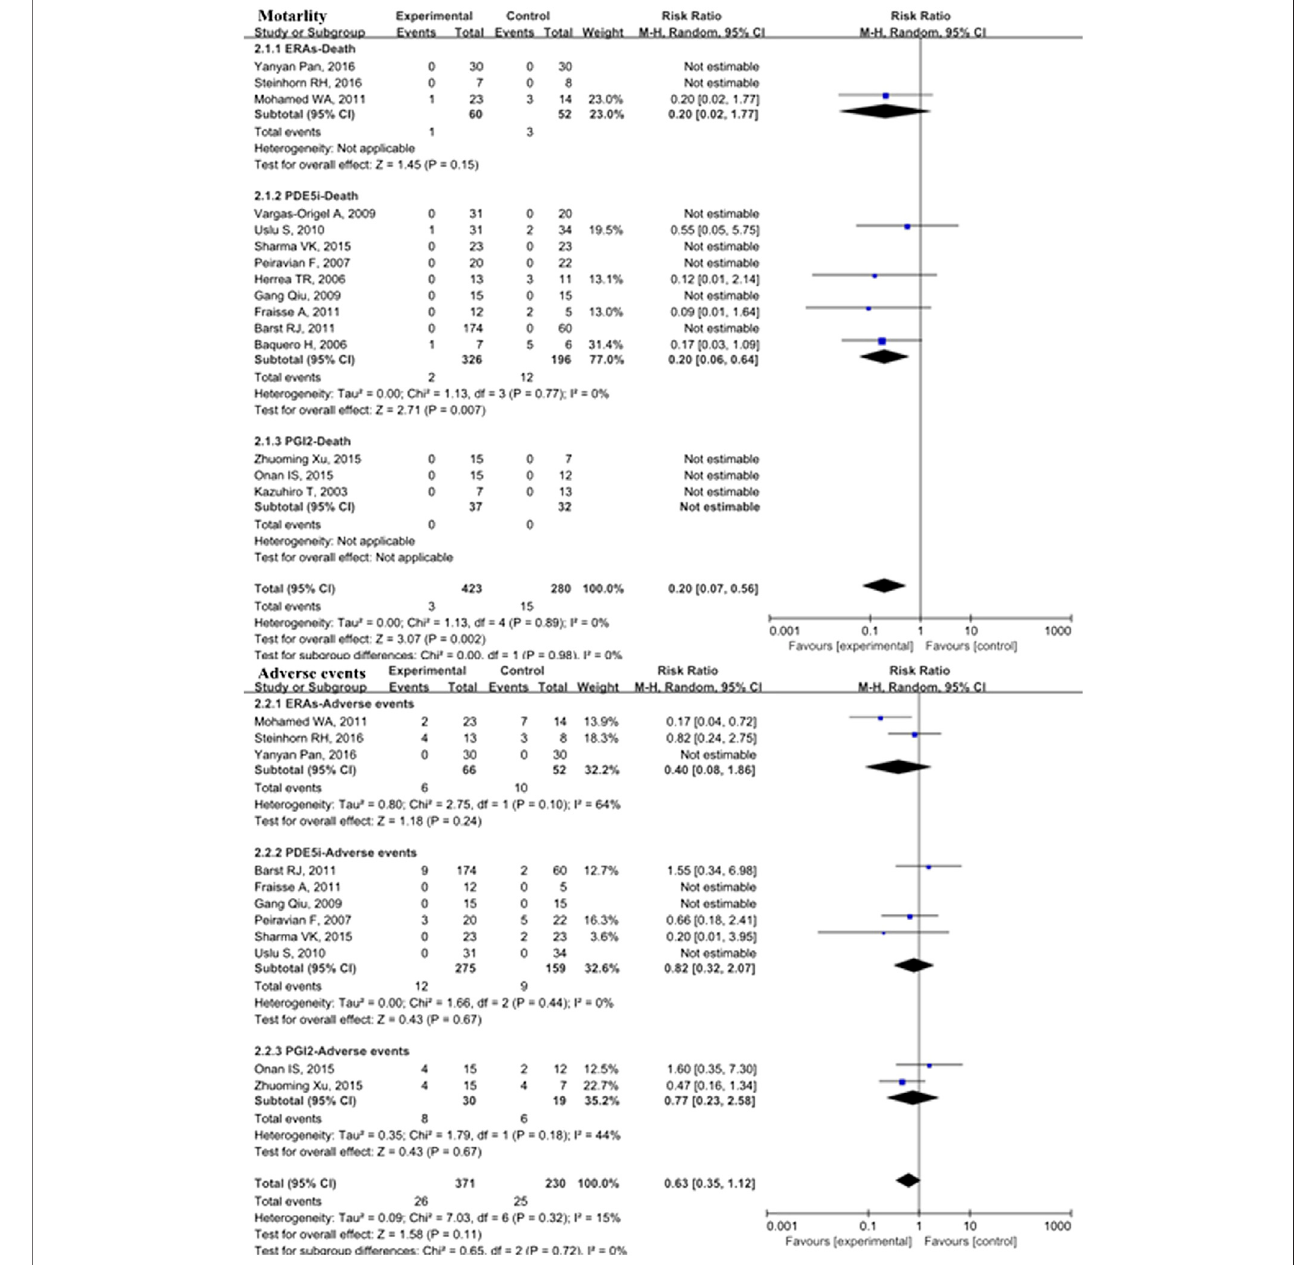
FIGURE 1 | Mortality and adverse events in pediatric PH patients treated with pulmonary vasodilators. Abbreviations ERAs, endothelin receptor antagonists; PDE5i, phosphodiesterase type 5 inhibitors; PGI2, prostacyclins; PPHN, persistent pulmonary hypertension of the newborn; POPH, pediatric postoperative pulmonary hypertension; PPAH, pediatric pulmonary arterial